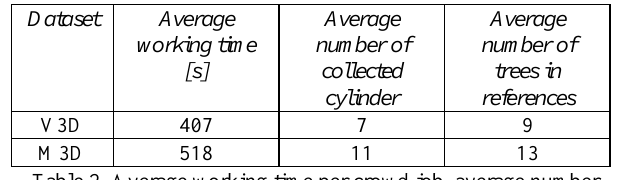
Table 2. Average working time per crowd job, average number of collected cylinders per crowd job and average number of trees in the corresponding reference for the V3D and M3D datasets